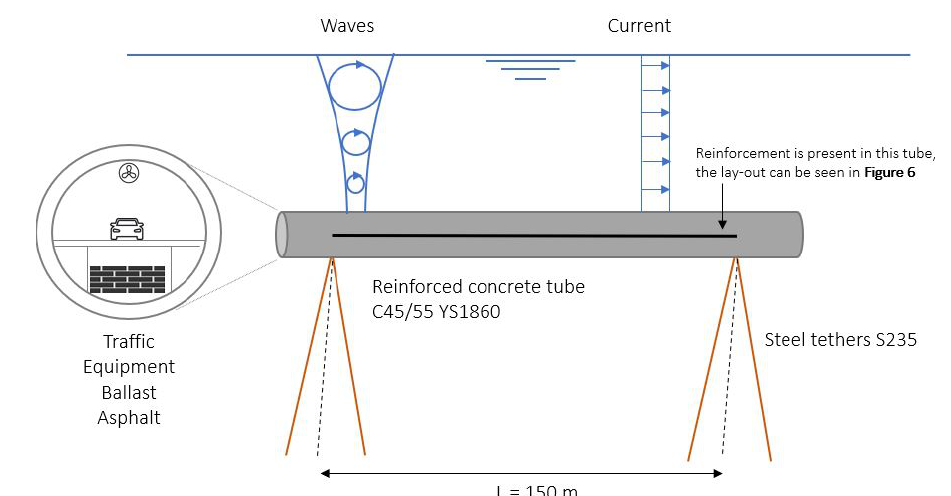
Figure 2. Simple model of SFT-element with loading